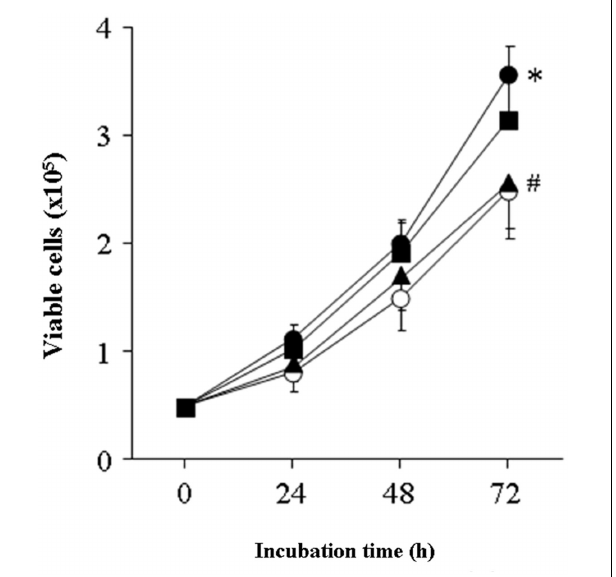
FIGURE 3 | Overexpression ofAKR1B10 elevates proliferation potential in U937 cells. U937 cells were cultured in Dulbecco’s modified Eagle’s medium supplemented with 10% fetal bovine serum and antibiotics, and transfected with the expression vector harboring the AKR1B10 cDNA as described previously (Endo et al., 2009).The cell expressed AKR1B10, which was not detected in the control cells transfected with the empty vector.The cells were seeded at a density of 5 × 10 4 cells/well into a 24-well • multiplate, and cultured for 24, 48, or 72h after addition of 0 ( ), 5 ( (cid:2) ), or (cid:2) 20 μ M ( ) of the AKR1B10 inhibitor, PHPC.The number of viable cells was evaluated by the trypan blue-dye exclusion method, and is expressed as the mean ± SD of three independent experiments. Since no significant effect of PHPC on growth of the control cells was observed, only the proliferation of ◦ the control cells without PHPC ( ) is depicted. *Significant difference • ( p < 0.05) for the overexpressing cells without PHPC ( ) from the control ◦ cells ( ). # Significant difference for the overexpressing cells with 20 μ M (cid:2) • PHPC ( ) from those without the inhibitor (